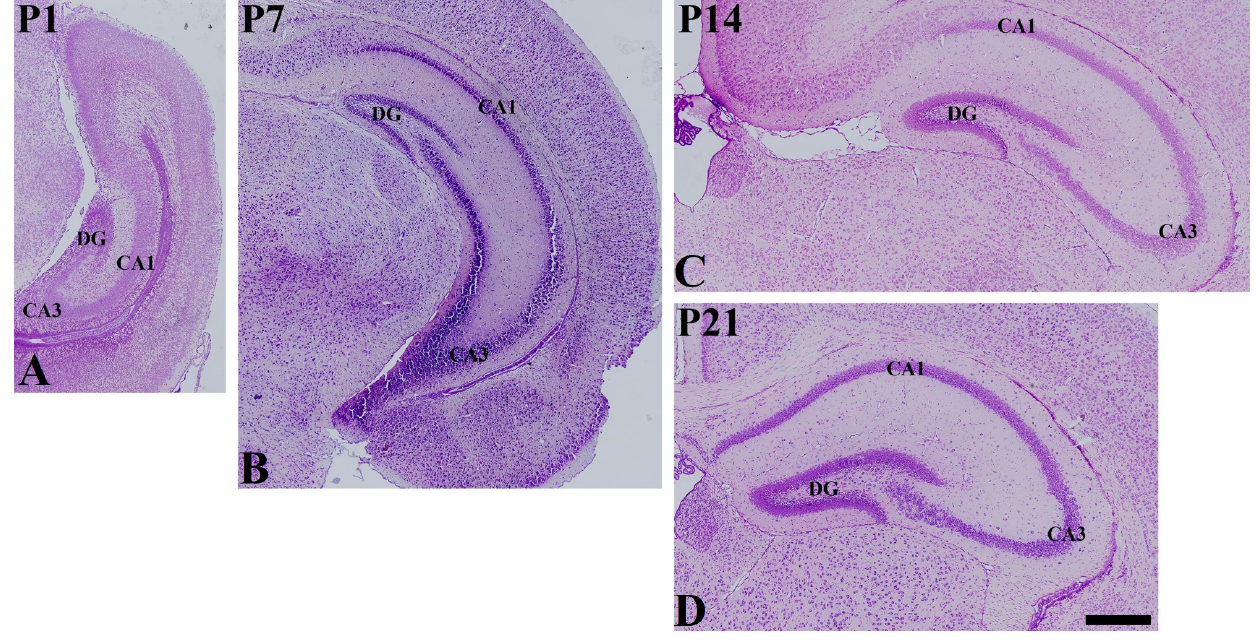
Figure 1. Cresyl violet staining in the mouse hippocampus at P1 ( A ), P7 ( B ), P14 ( C ), and P21 ( D ). DG dentate gyrus. Scale bar = 400 µm.